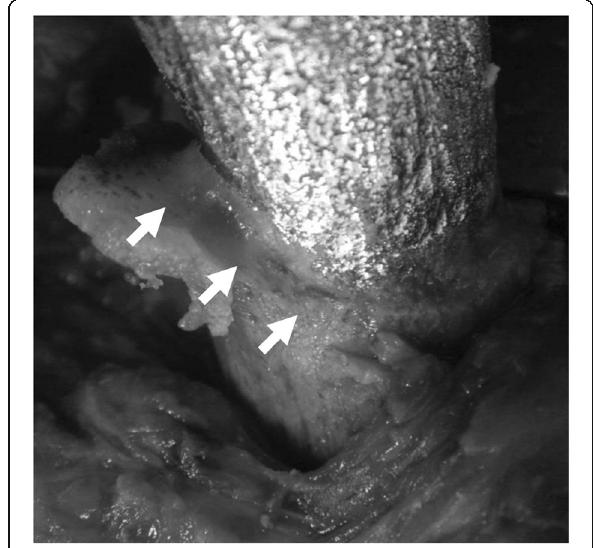
Fig. 3 Intraoperative findings of the Case 1; Thorough debridement of the proximal femur was performed using a high-speed burr until fresh, clean bone ingrowth was identified